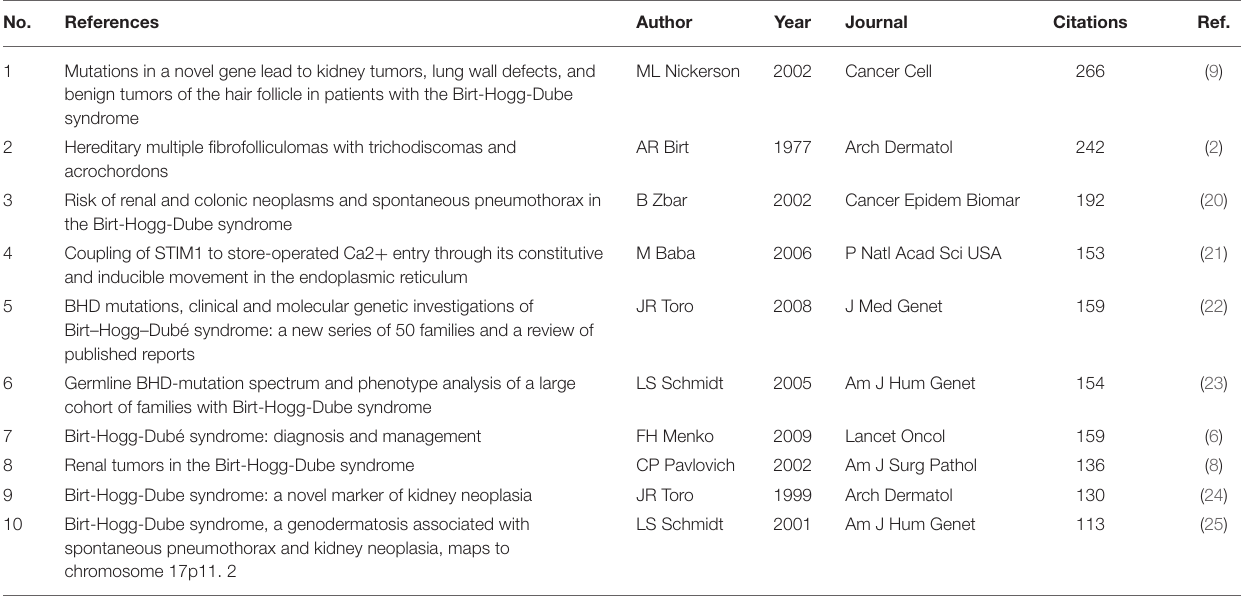
TABLE 6 | The top 10 co-cited references related to